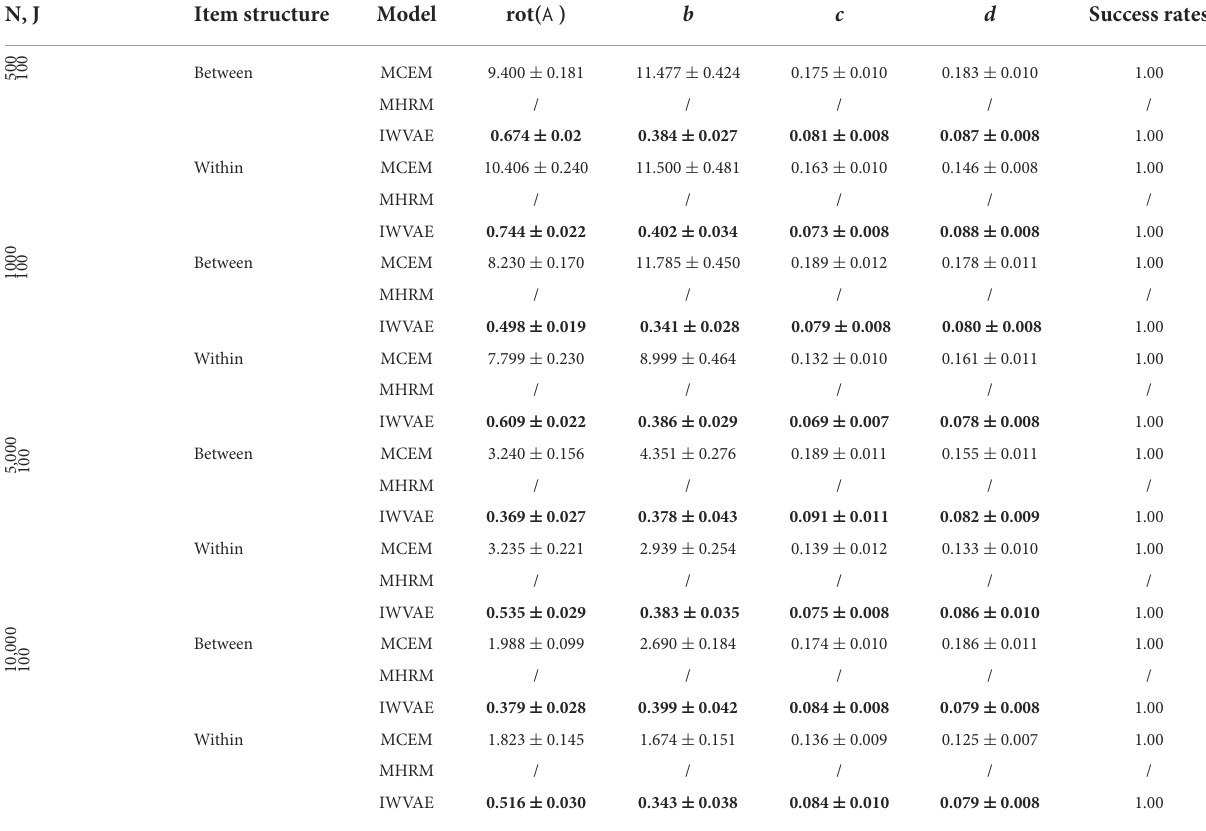
TABLE 1 Mean and SE of RMSE of M p estimate on M4PL models under single regime setting, best results are in bold. N, J Item